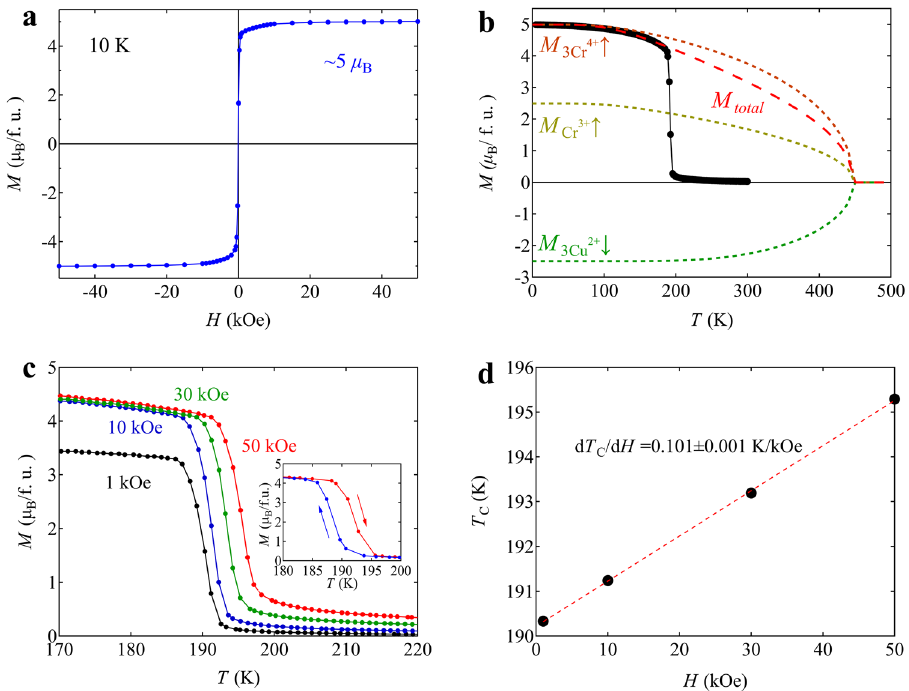
Figure 2. ( a ) Magnetization curve of the ferrimagnetic BiCu 3 Cr 4 O 12 at 10 K. ( b ) Temperature dependence of magnetization for BiCu 3 Cr 4 O 12 measured under 10 kOe. The red dash line represents the fitting for the total magnetization curve with the Brillouin function below the magnetic transition temperature. Contributions of Cr 3+ ( S = 3/2) ↑ , 3Cr 4+ ( S = 1) ↑ , and 3Cu 2+ ( S = 1/2) ↓ moments to the ferrimagnetization are shown in yellow, orange, and green dotted lines, respectively. ( c ) Temperature dependent magnetization curves for BiCu 3 Cr 4 O 12 measured at various applied fields from 1 to 50 kOe in a field-cooling mode. The inset shows the thermal hysteresis between cooling (blue) and heating (red) at 10 kOe. ( d ) The magnetic field dependence of the transition temperature determined by the inflection points of magnetization curves. The dashed red line shows the linear fit of the